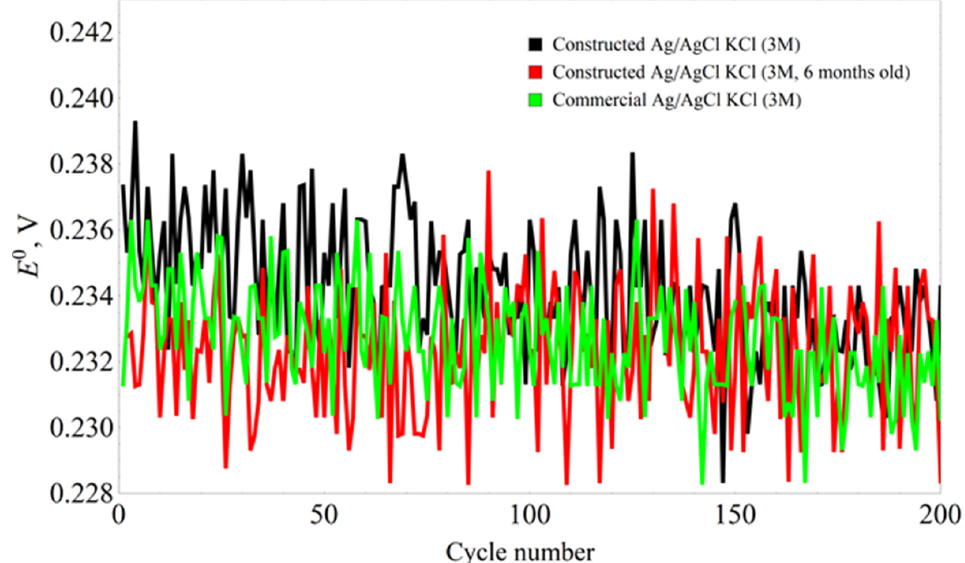
Figure 4. Assessment of redox potential stability during long lasting cyclic voltammetry-based experiment. Two hundred potential cycles were performed. During experiments, freshly made reference electrodes and those of six months of storage were compared with commercial reference electrodes. CV recorded in 0.1 mM hydroxymethylferrocene (HMF), potential sweep rate–100 mV/s.